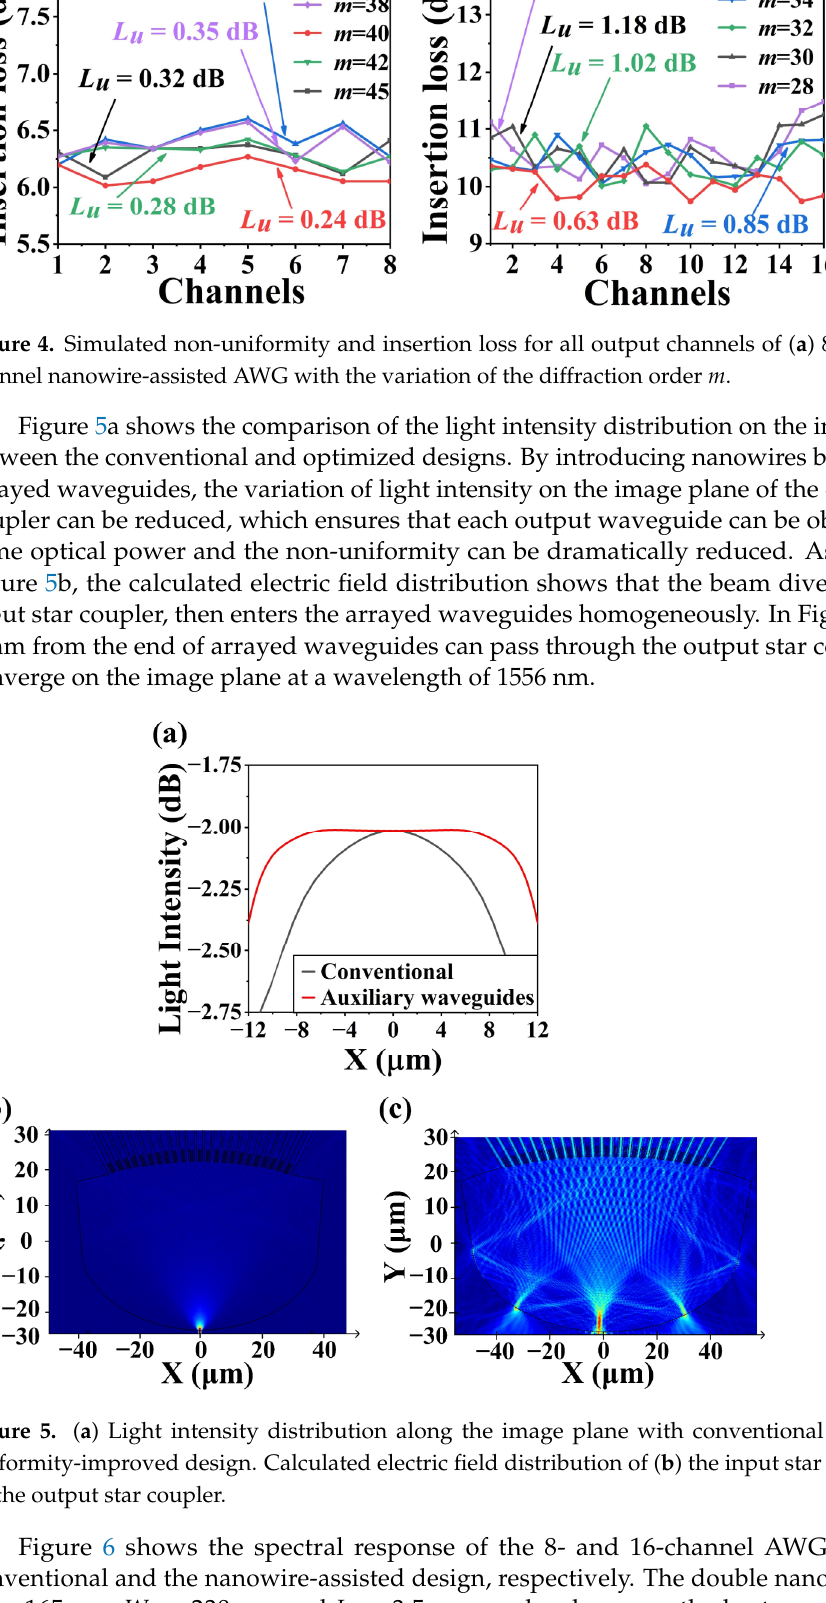
6 of 11 Figure 3. Simulated non-uniformity and insertion loss for all output channels of ( a ) 8 and ( b ) 16- channel nanowire-assisted AWG with the variation of N 1 . It is important to investigate the influence of diffraction order ( m ) on non-uniformity and insertion loss. Figure 4 demonstrates the non-uniformity and insertion loss of all out- put channels with change of diffraction order. The non-uniformity for an 8-channel AWG